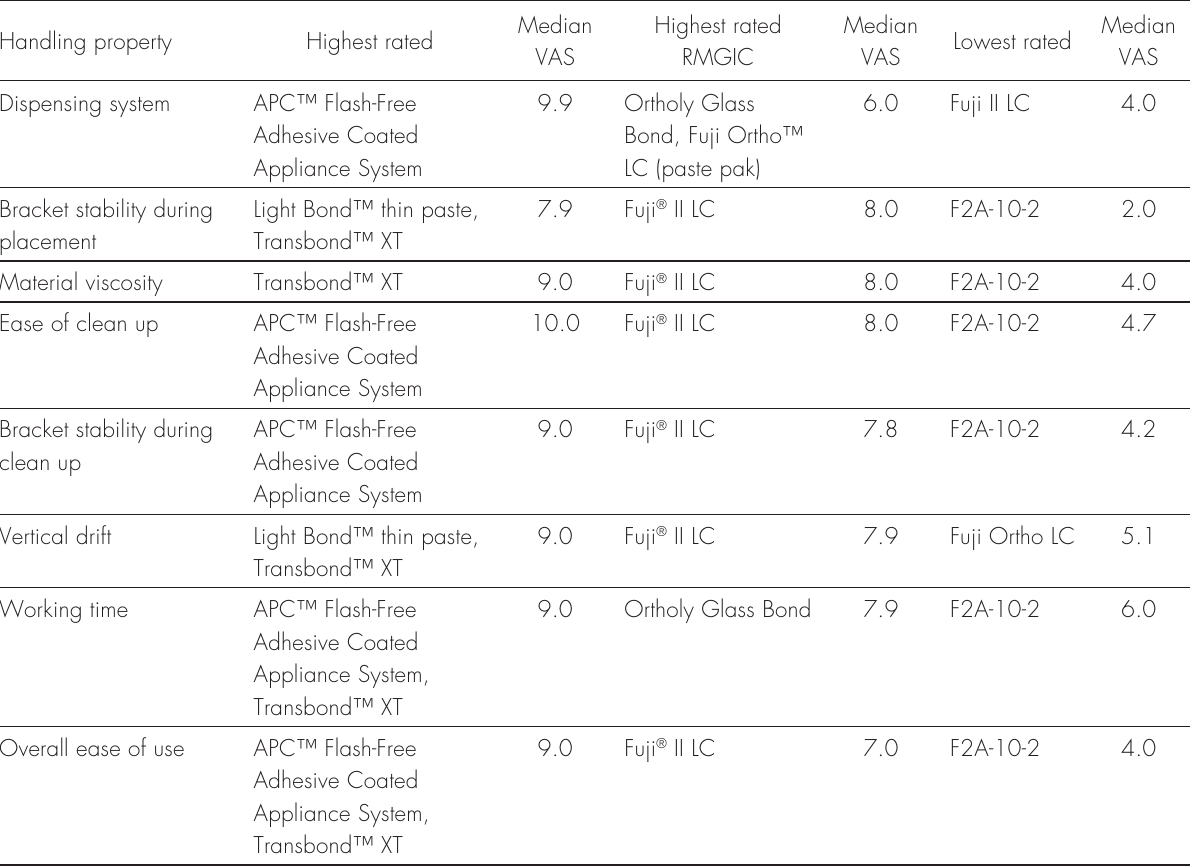
Table III. All materials were rated using a 10.0 cm visual analogue scale (VAS), for each handling property assessed. Highest median VAS scores with corresponding materials of all materials trialled, highest median VAS scores with corresponding materials of all RMGIC materials, lowest median VAS scores with corresponding materials of all materials trialled, for each handling property